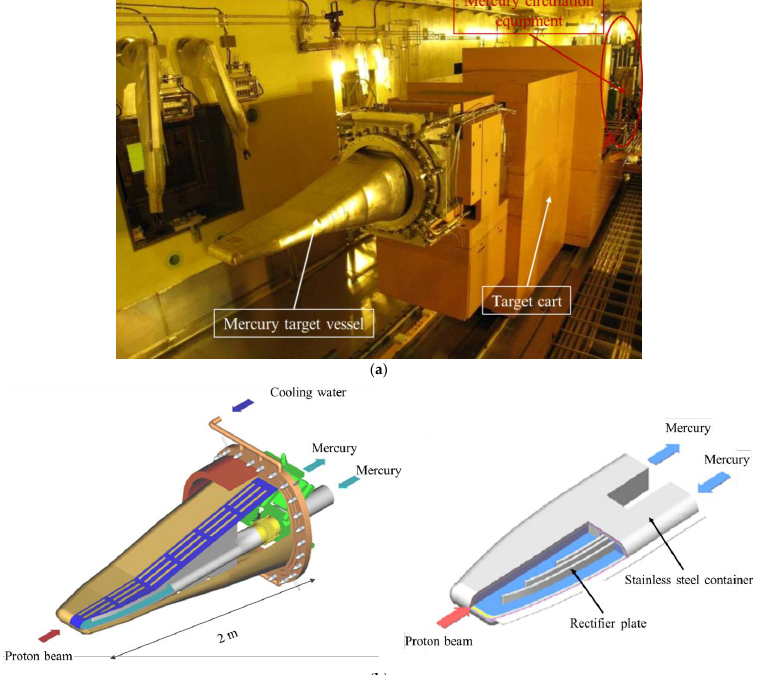
Figure 1. Appearance and model of mercury target ( a ) Appearance of mercury target system ( b ) Model diagram of target vessel and mercury vessel. 2.2. Experimental Specimen In this research, the specimen was polished by a grinder, and a mirror-polished sur- face (less than 1 μm) was obtained before the experiment. The appearance and basic di-